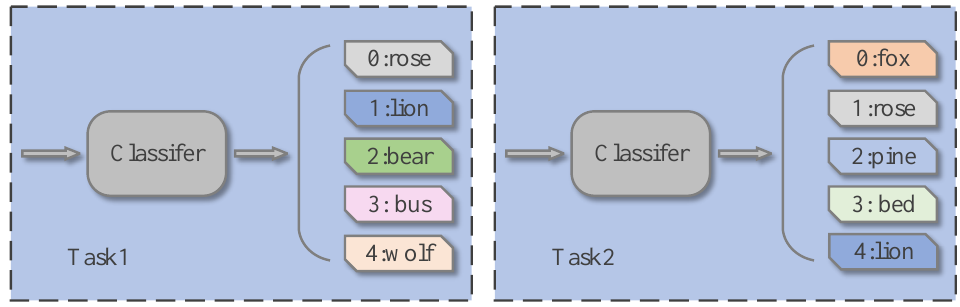
Figure 6. Two different types of tasks.